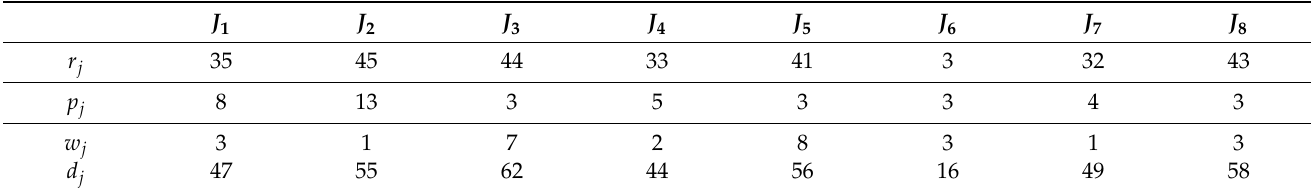
Table 4. Job-position trajectory ( JPT ) matrix from 1000 random solutions for 8-job instance. Positions